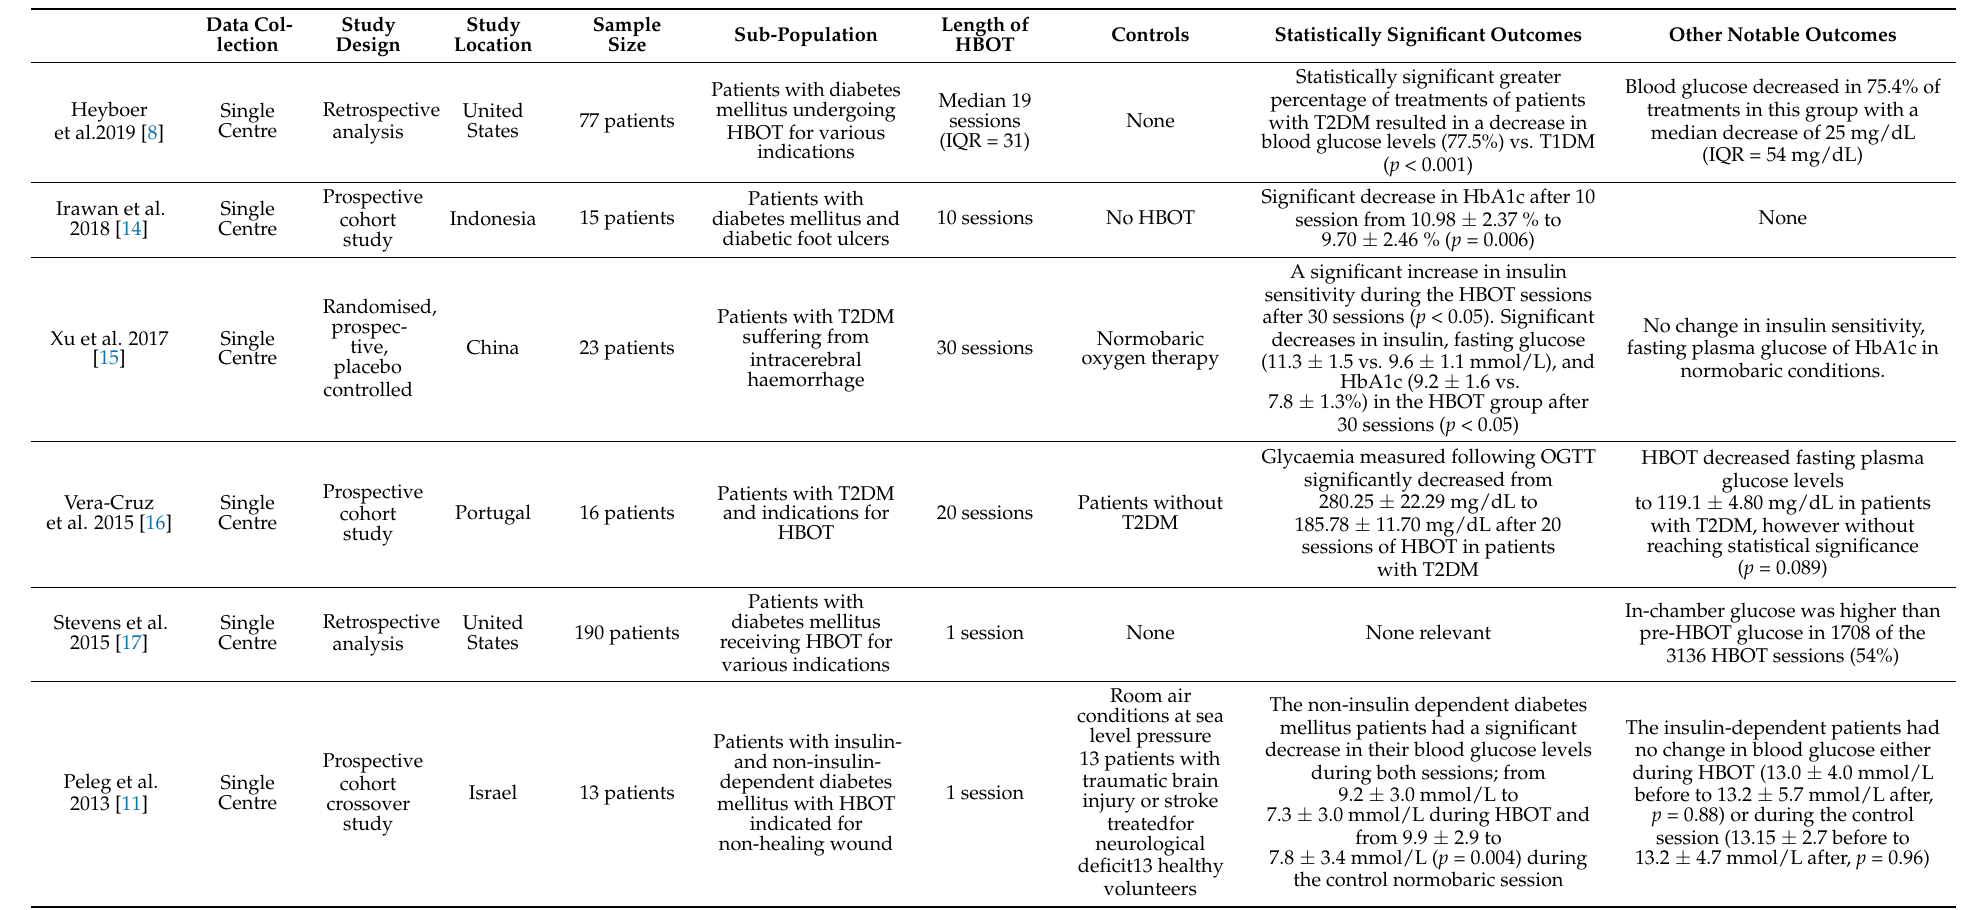
Table 3. Summary of the characteristics and findings of the ten eligible original research studies included in this review. DM = Diabetes Mellitus HTN = Hypertension, HBOT =